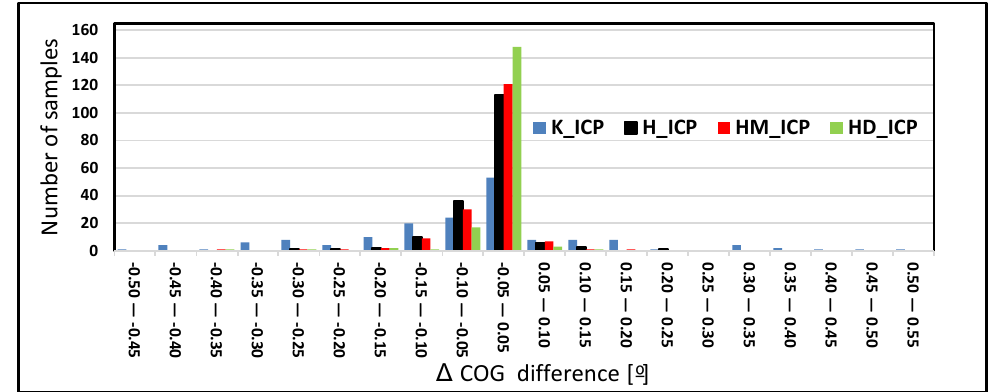
Figure 15. A histogram representing the frequency of occurrence of ΔCOG ICP − ΔCOG R increments.